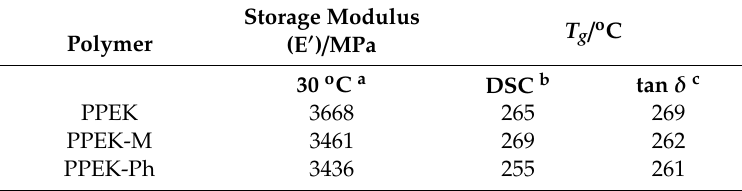
Table 5. Storage modulus and Tg values of the resins measured by DMA Storage Polymer